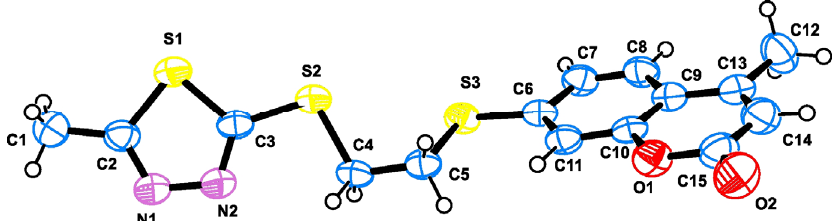
Figure 2. A representation of the molecule present in the asymmetric unit of compound 3 along with the employed numbering scheme; atomic displacement parameters (ADPs) are at 50%, hydrogen atoms are shown as small spheres with arbitrary radii.